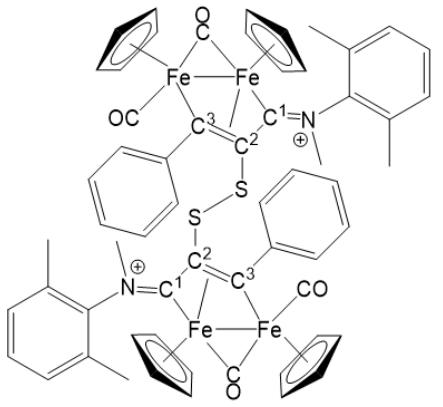
Chart 5. Structure of the cation of 4b .